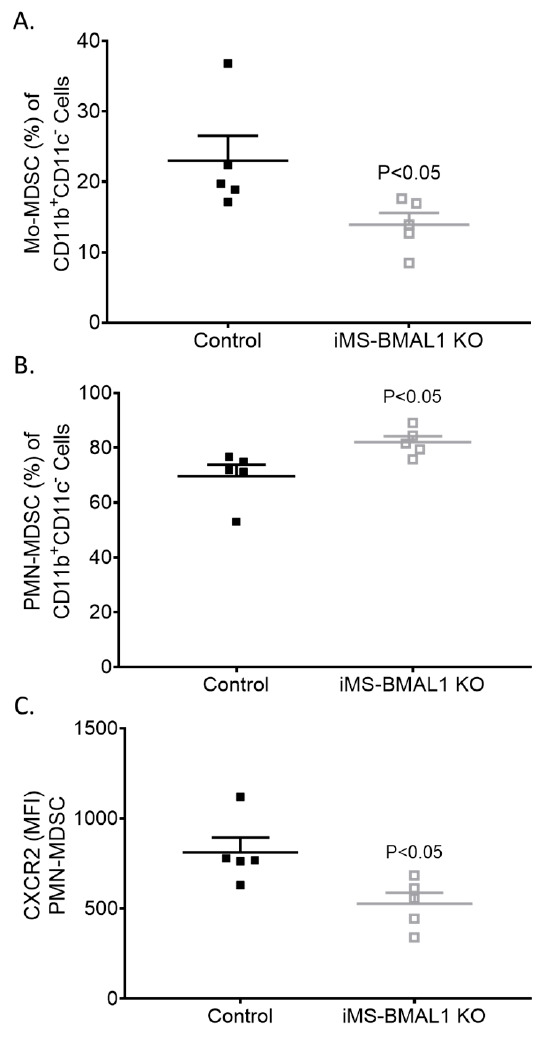
Figure 5. Lungs from iMS-BMAL1 KO had increased immunomodulatory immune cell infiltration. ( A ) Percentage of monocytic and ( B ) polymorphonuclear myeloid-derived suppressor cells in lung tissue from control and iMS-BMAL1 KO mice assessed via flow cytometry. ( C ) Chemokine receptor CXCR2 expression was determined per PMN-MDSC population. n = 5. All data are presented as mean ± SEM. The Student’s t -test was used for comparisons between groups. Mo-MDSC = monocytic myeloid-derived suppressor cells; PMN-MDSC = polymorphonuclear myeloid-derived suppressor cells; CXCR2 = CXC motif chemokine receptor 2; MFI = mean fluorescence intensity.